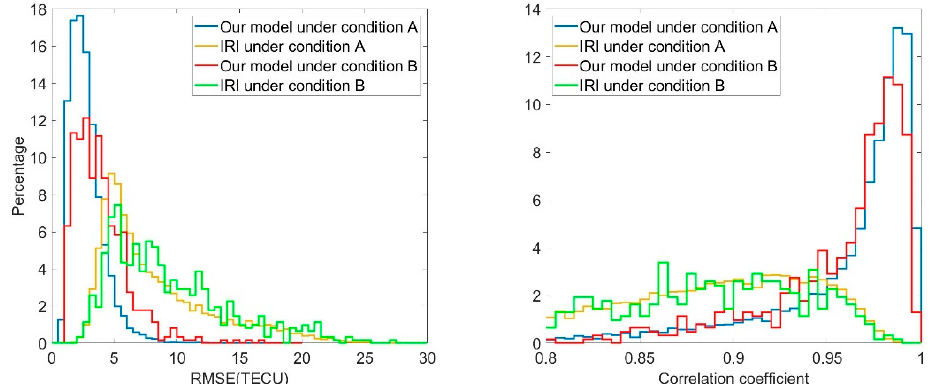
Figure 5. The distribution of RMSEs ( left ) and CCs ( right ) between the output maps and the target maps, as well as between IRI TEC maps (+2 h) and the target maps under different geomagnetic conditions for the test set.